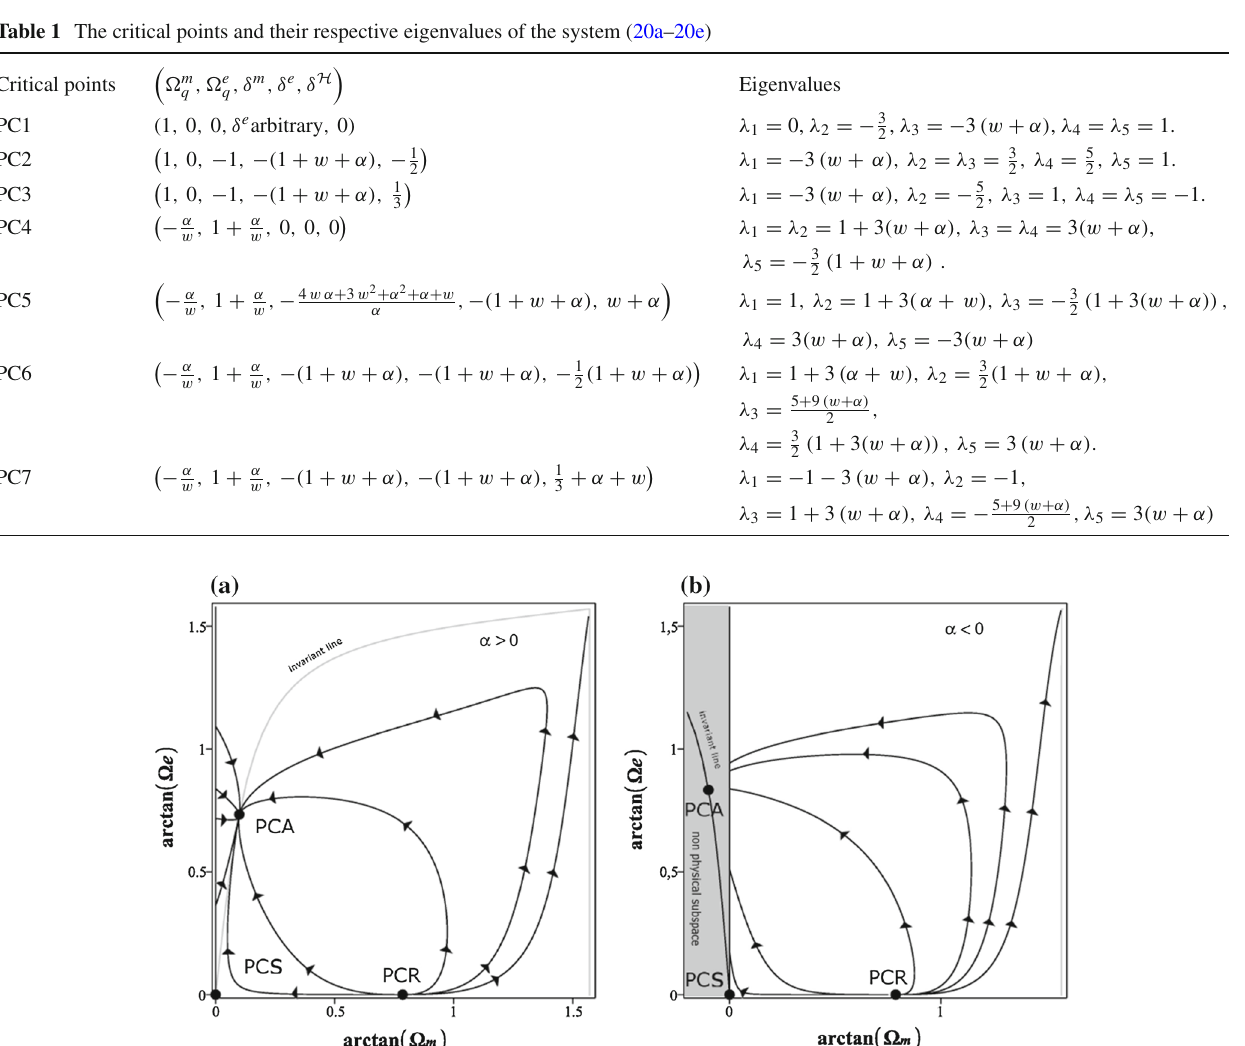
Fig. 1 a Critical points and numerical trajectories of the dynamical system (20a–20e) in the homogeneous projection for α = 0 . 1 and w = − 1 . 0. For other choices of the parameters with α > 0 the point PC A will be in a different position, and, consequently, the invariant line will have a different slope. For some initial conditions choice, the trajectory evolves to the future attractor PC A from the (cid:12) m q = 0 axis or